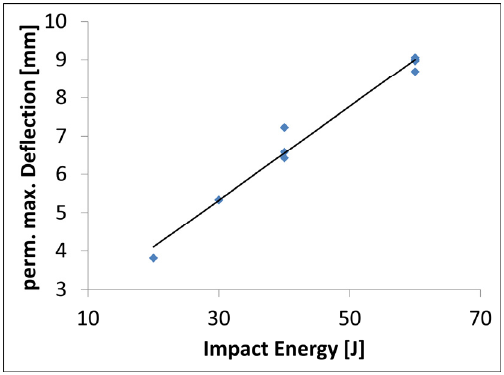
Figure 7. Maximum deflection over impact force of the tested FML.